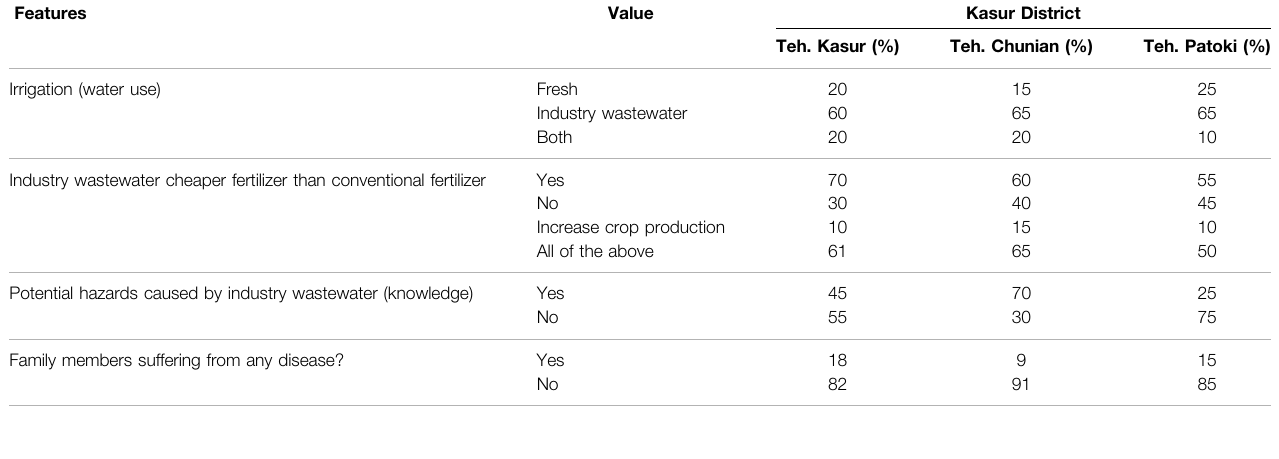
TABLE 2 | Industry waste water use (irrigation).